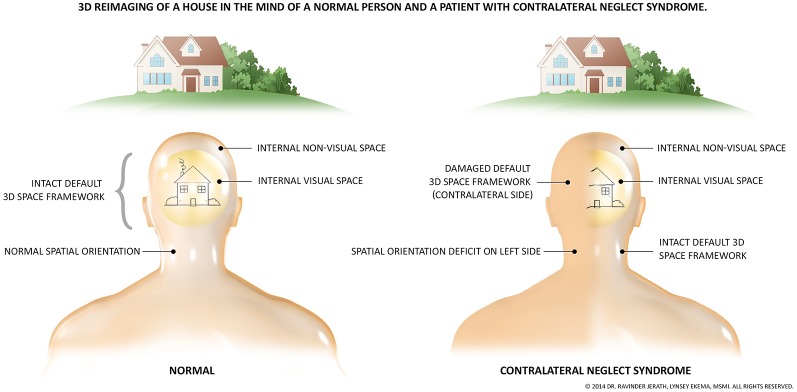
The fundamental presence of an unconscious, 3D, virtual coordinate matrix. The necessity of a virtual, spatial matrix for the existence of the human and likely all animal consciousness is illustrated by the symptoms of contralateral neglect syndrome. This syndrome most often arises from right-hemispheric damage to the right parietal lobe. Due to damage to networks related to spatial processing, one side of one’s perceptual space ceases to consciously exist, illustrated by this figure. As depicted, not only does visual perception disappear, but all perception of that side is removed. These patients are not aware of the missing space, and the side remaining is experienced as the full physical world. Stimuli from the missing side are still processed however, but remain outside of consciousness. The image previously published in Jerath and Crawford (2014); permission provided by Copyright Clearance Center, Inc, Copyright © 2014 Elsevier Inc.